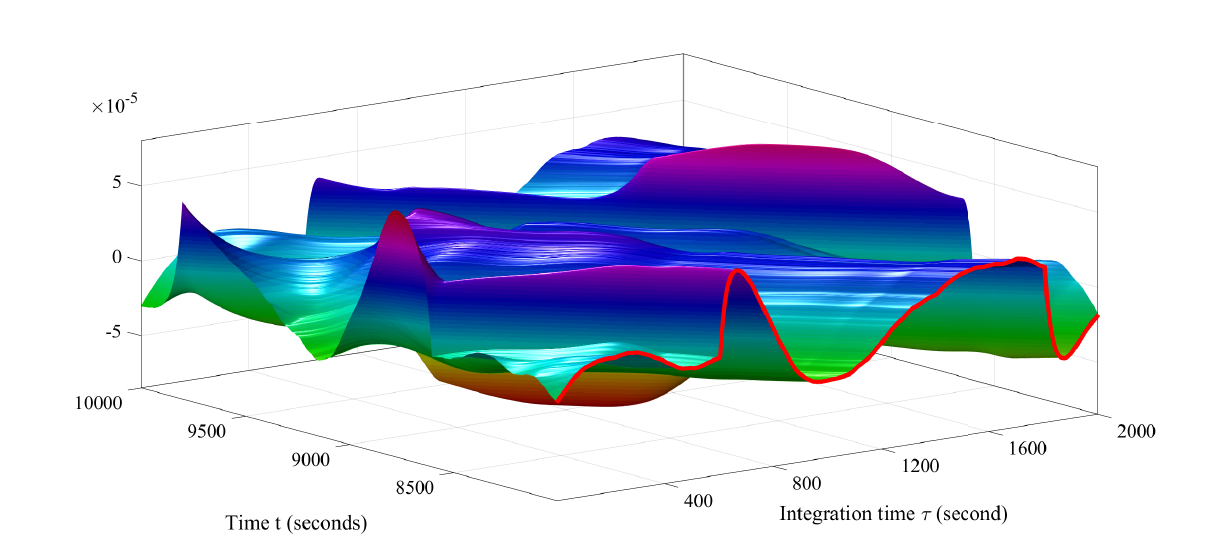
Figure 8: Evolution of the modulation